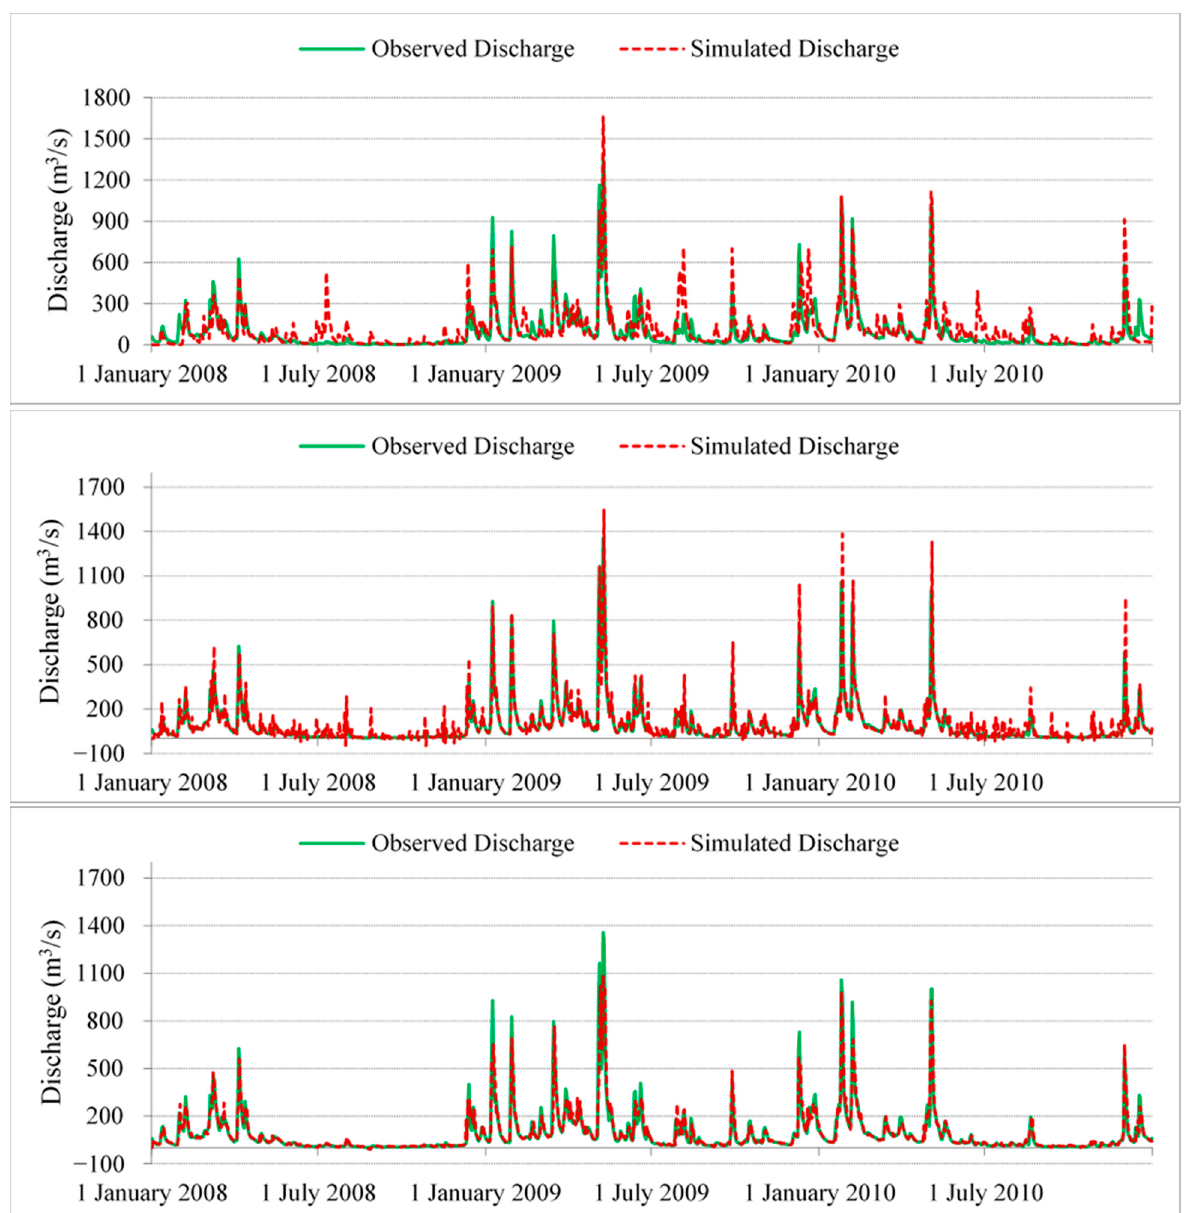
Figure 10. Daily discharge validation for SWAT ( top ), ARX ( middle ), and GEP ( bottom ) at LD14 for time period 2008–2010.